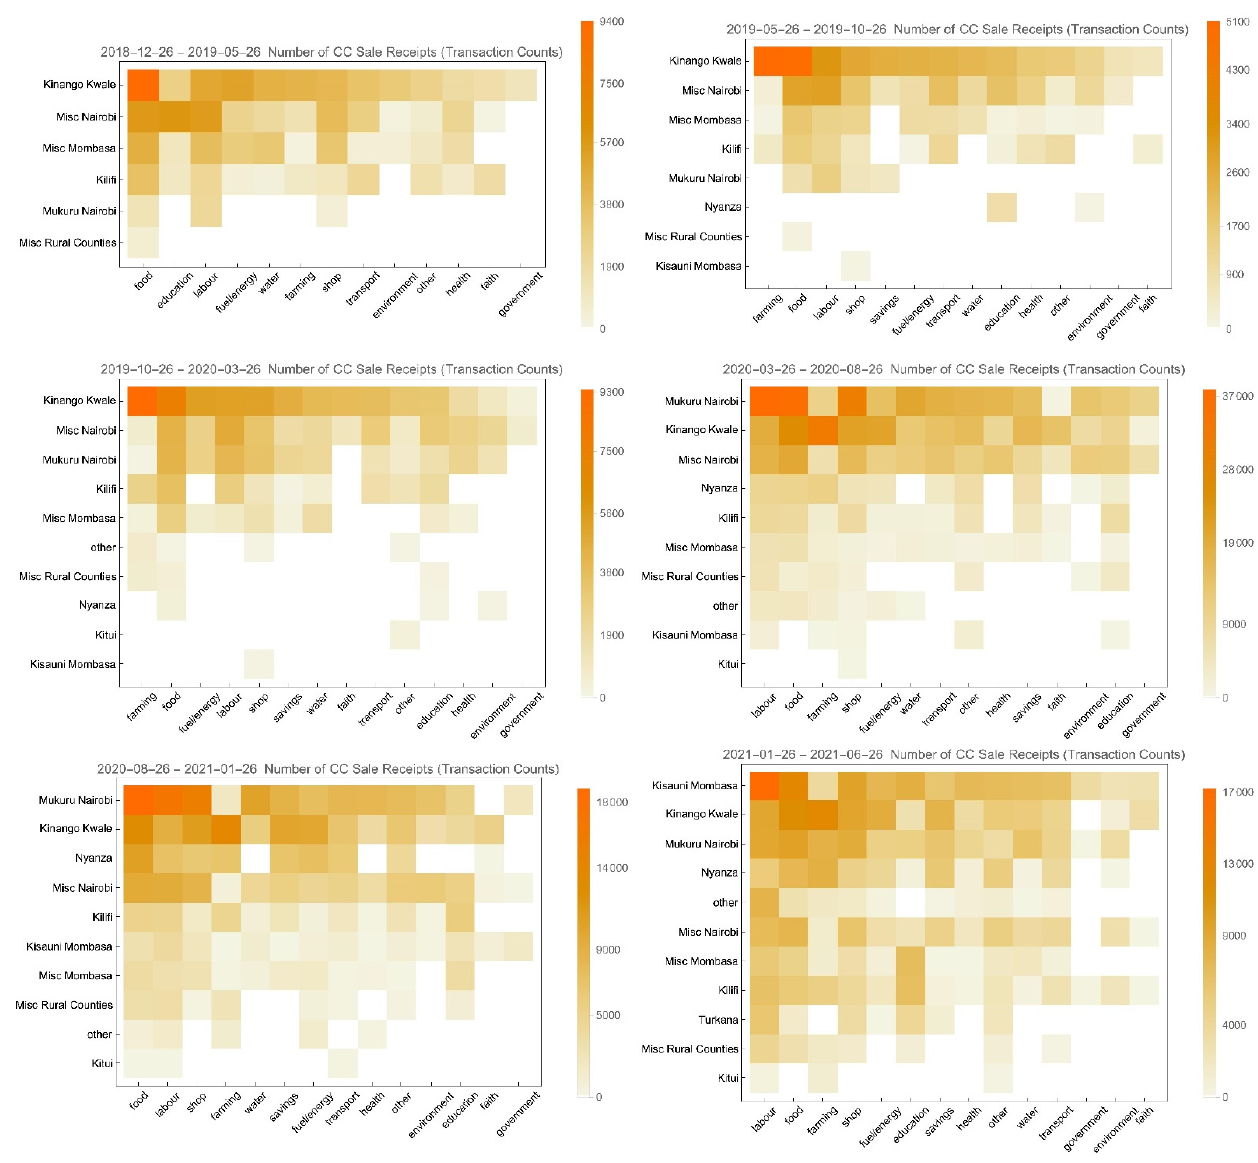
Figure 12. Backward Linkages: diversity-ubiquity production space for the entire CC membership. Starting in the first 5 months from 26 December 2018, to the last 5 months ending in 26 June 2021. First row is ranked by sales count per vendor-type by region. Then first column is ranked by sales count per region by the highest vendor-type.